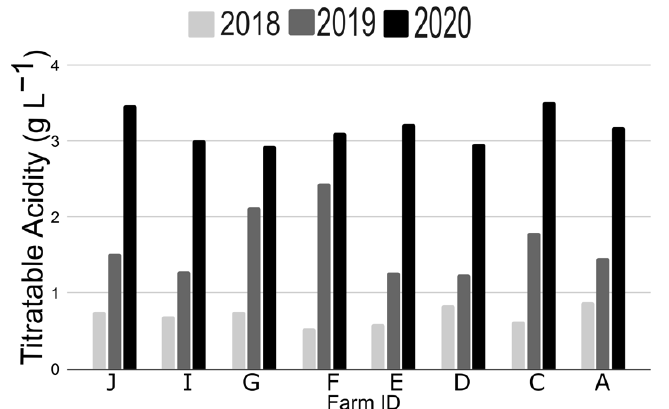
Figure 5. Titratable acidity of “Jewel” between 2018, 2019, and 2020. Each letter corresponds to an individual farm in New York State. One sample was collected per farm between early June and early July. Differences between years were significant ( p < 0.0001) when treating farms as replicates, but not between farms when treating year as a replicate.